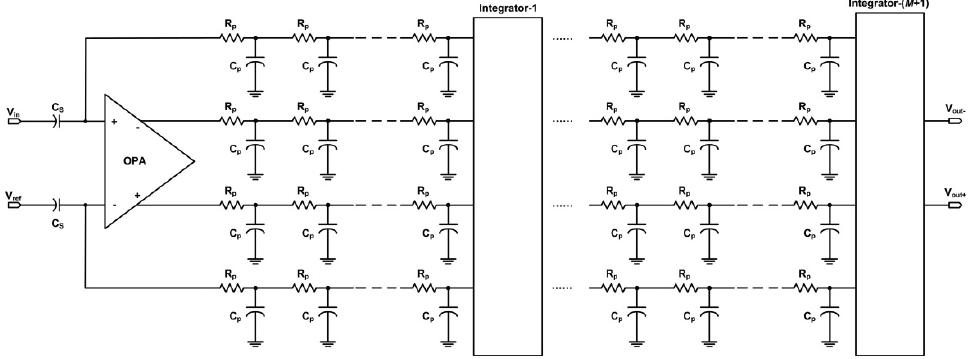
Figure 4. Parasitic resistors and capacitors in the buses of the accumulator.